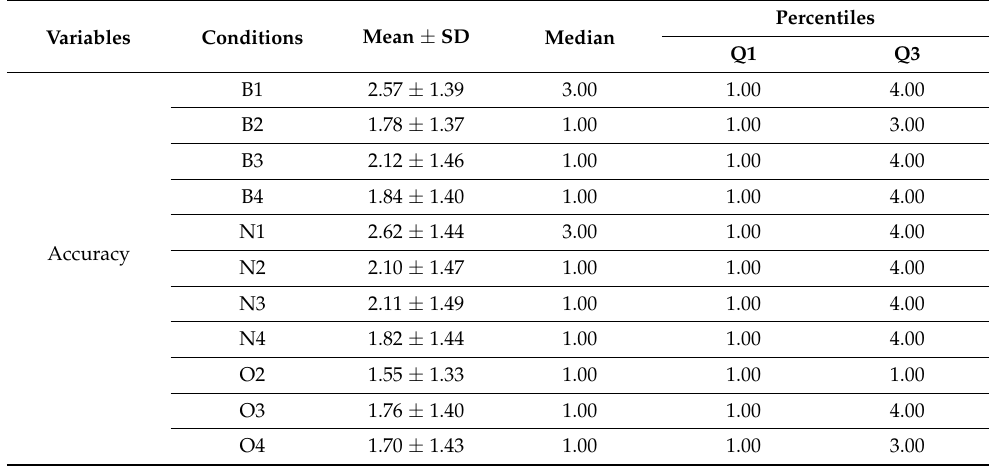
Table 3. Descriptive statistics in points (mean ± standard deviation, median, Q1 and Q3) in terms of accuracy for the sample (n =